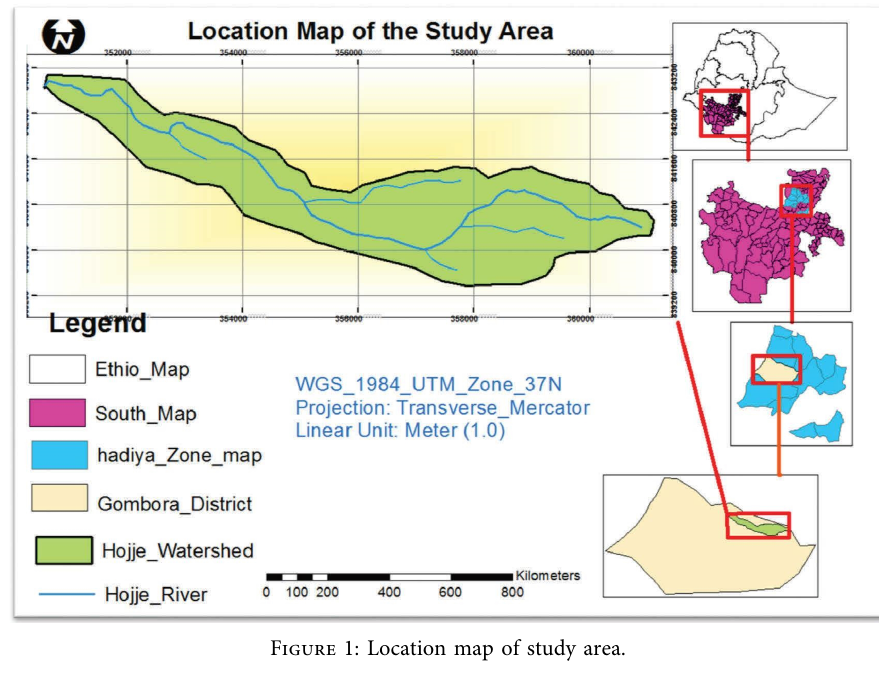
Figure 1: Location map of study area.